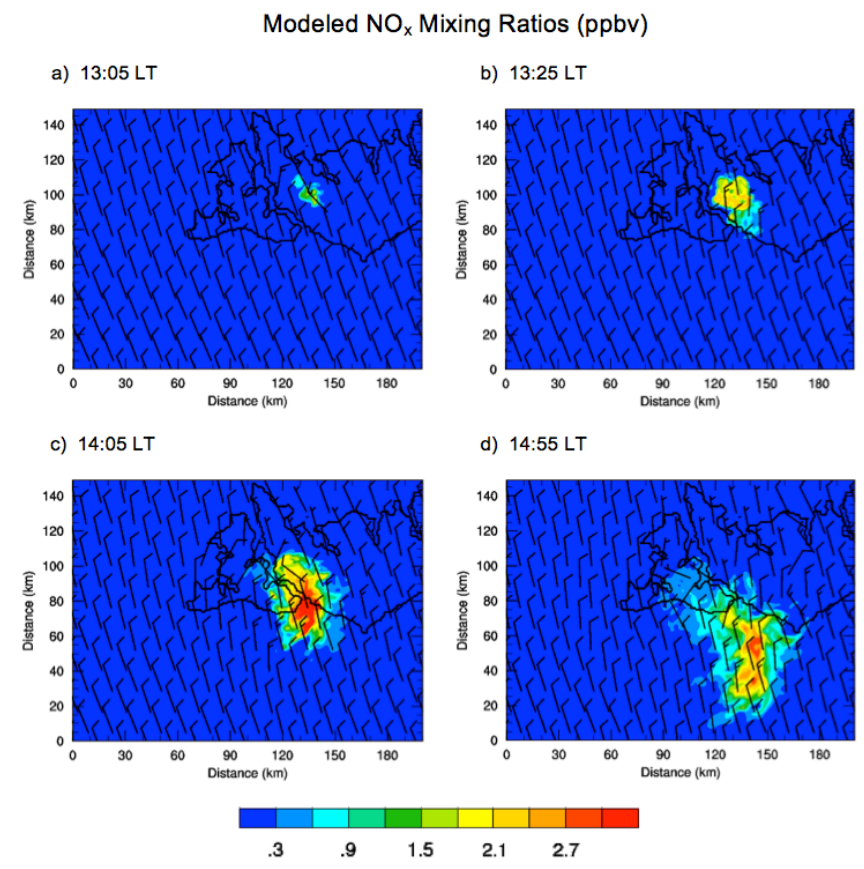
Fig. 14. Time series of NO x mixing ratios at 13km for simulations with lightning NO production of 500molesflash − 1 at (a) 13:05LT, (b) 13:25LT, (c) 14:05LT, and (d) 14:55LT. Arrows indicate wind vectors at 13km. Wind speed is reported in ms − 1 , where a full barb is equivalent to 10ms − 1